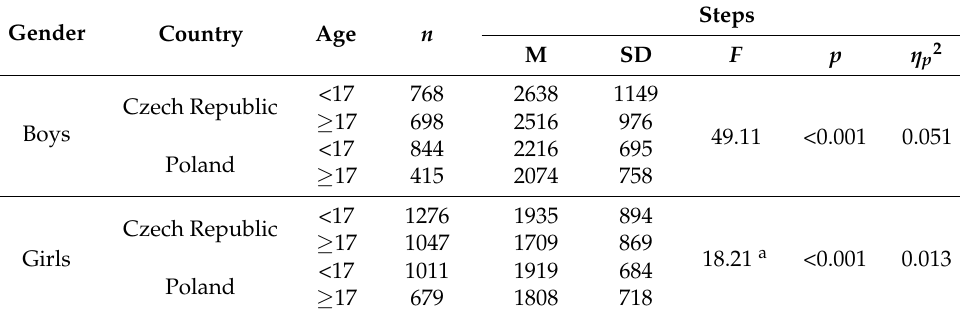
Table 2. Step counts per PE lesson of boys and girls by age.